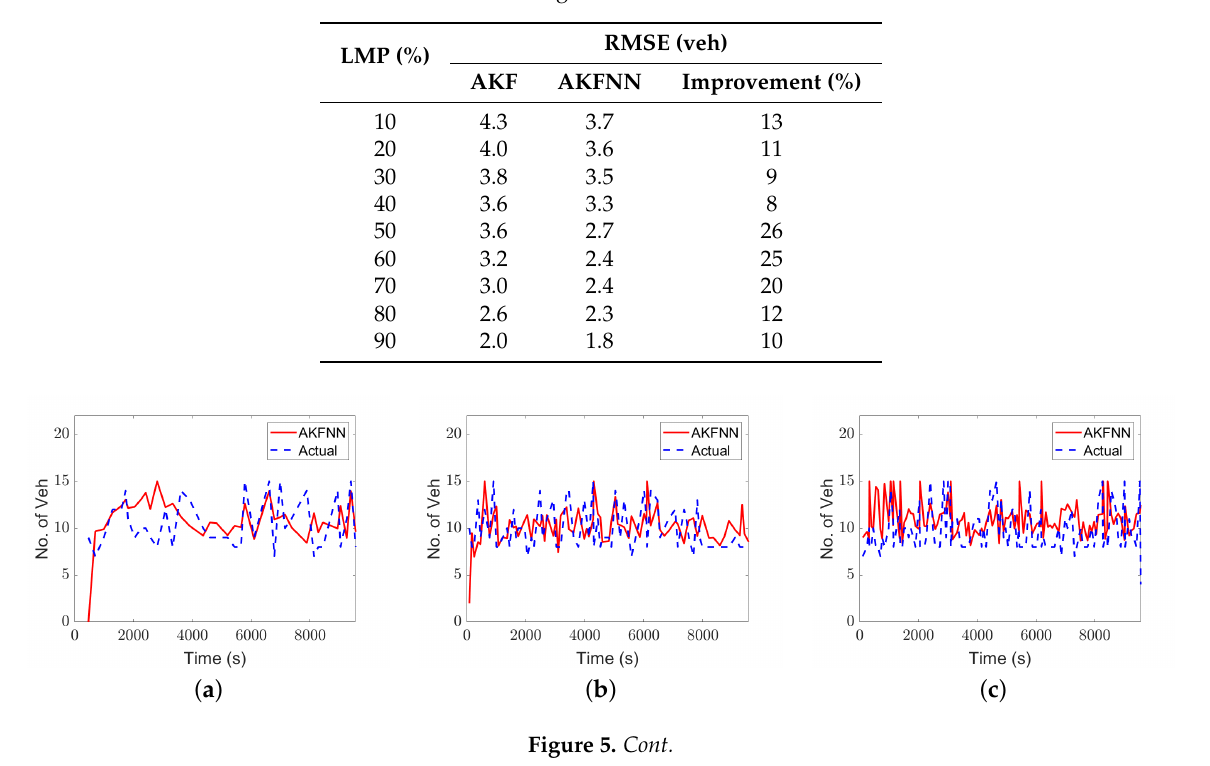
Table 4. RMSE values using the AKF and the AKFNN